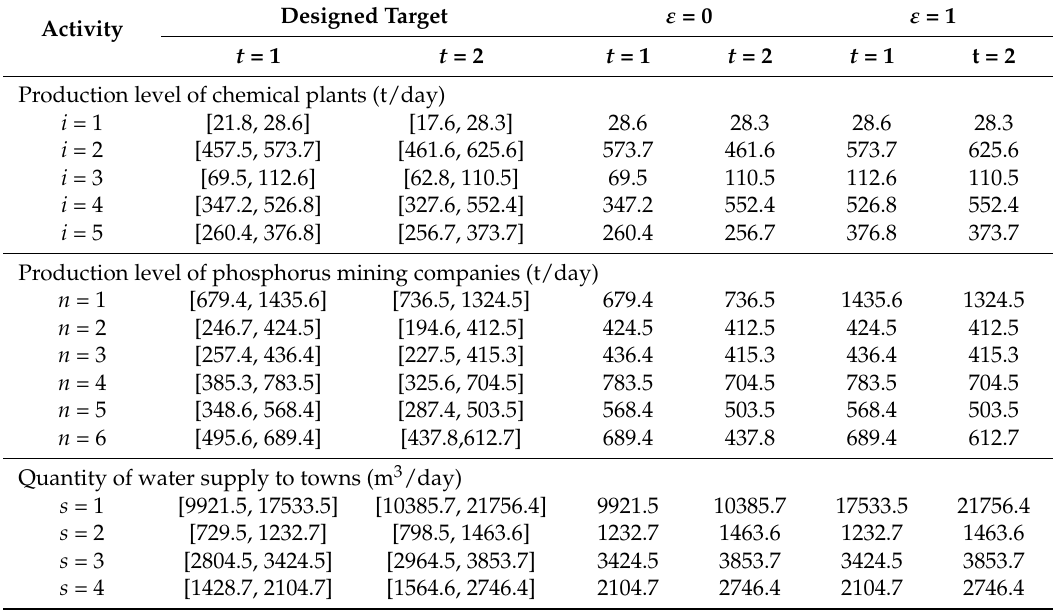
Table 3. Optimal production targets under different ε